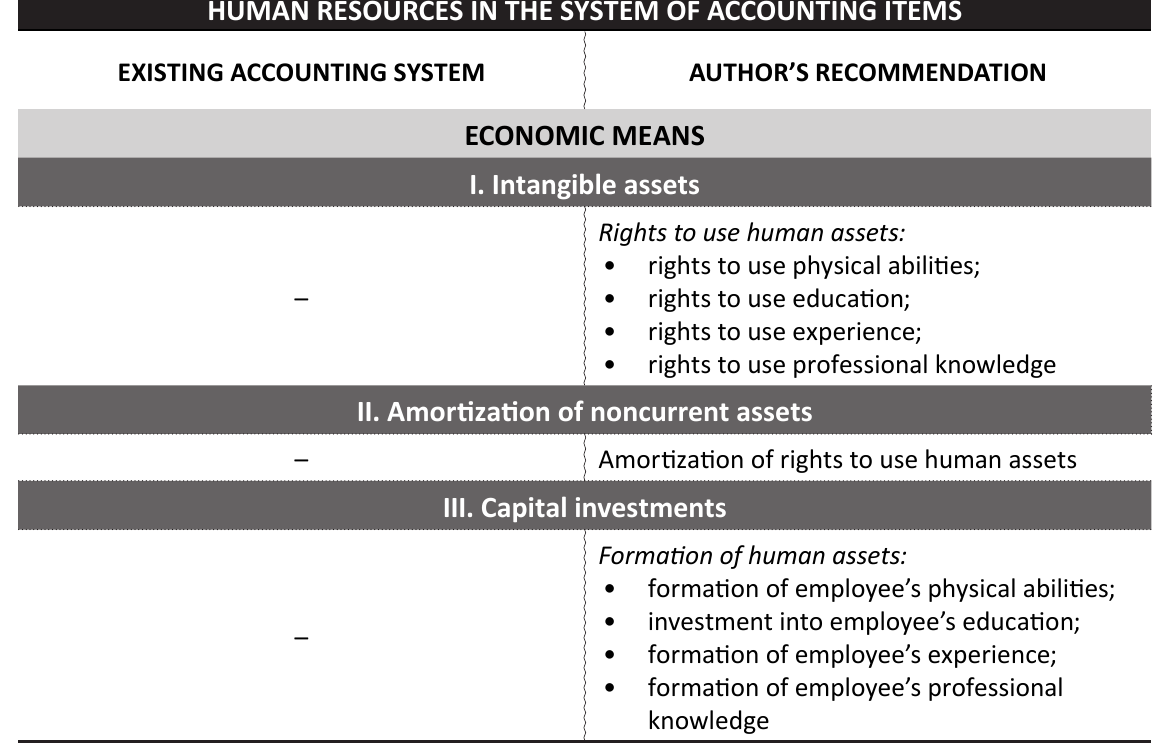
Figure 1. Human resources in the system of accounting items